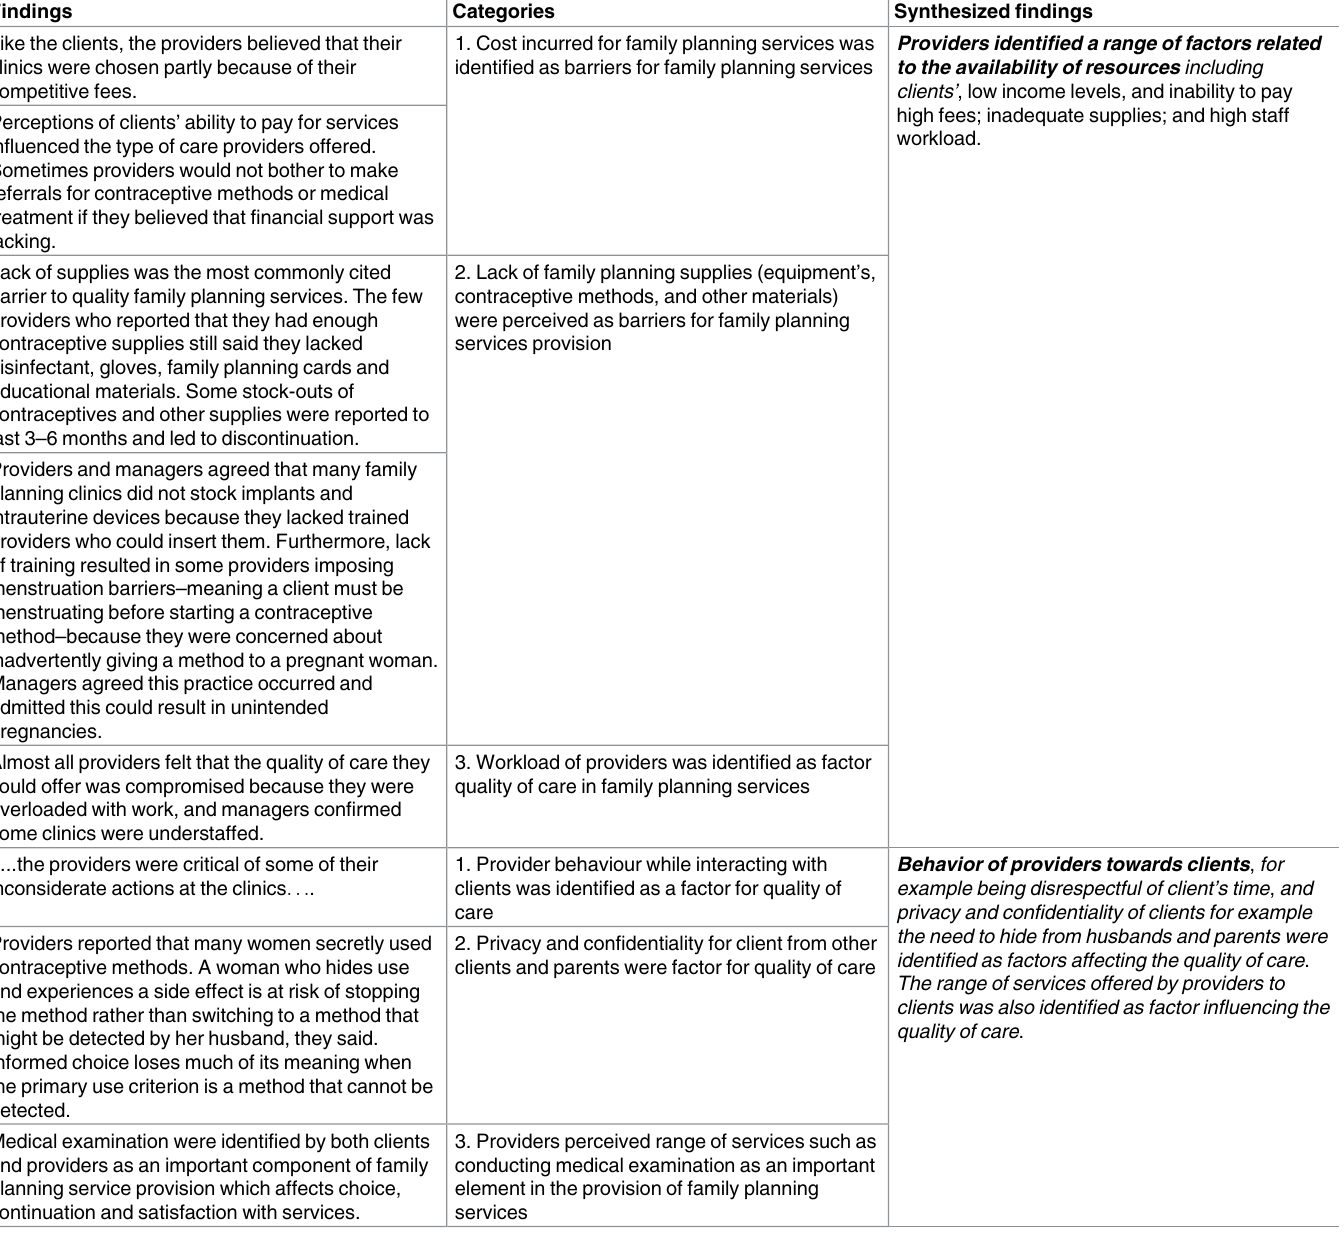
Table 5. Synthesis of qualitative findings on how providers perceive factors determining the quality of care in family planning